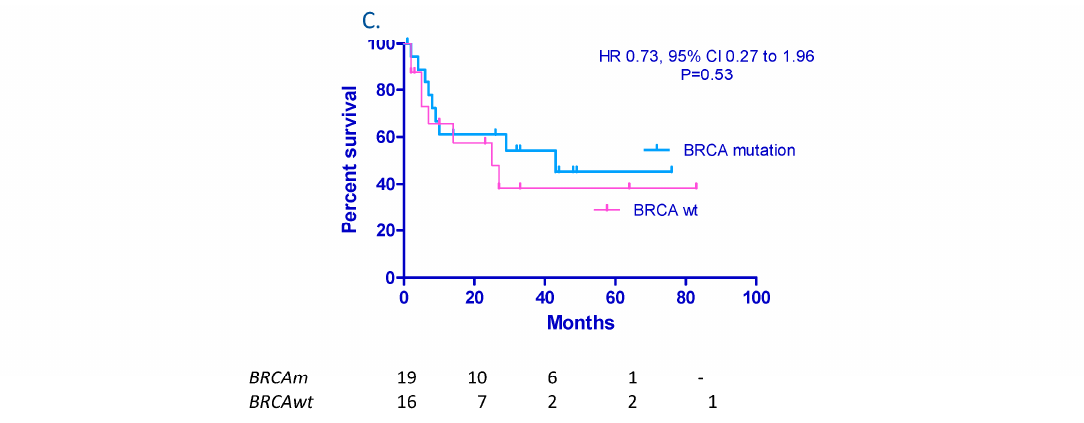
Figure 4. Median OS according to platinum sensitivity ( A ), PARPi vs. no PARPi maintenance treatment in platinum sensitive relapse cohort ( B ), and BRCA status ( C ).